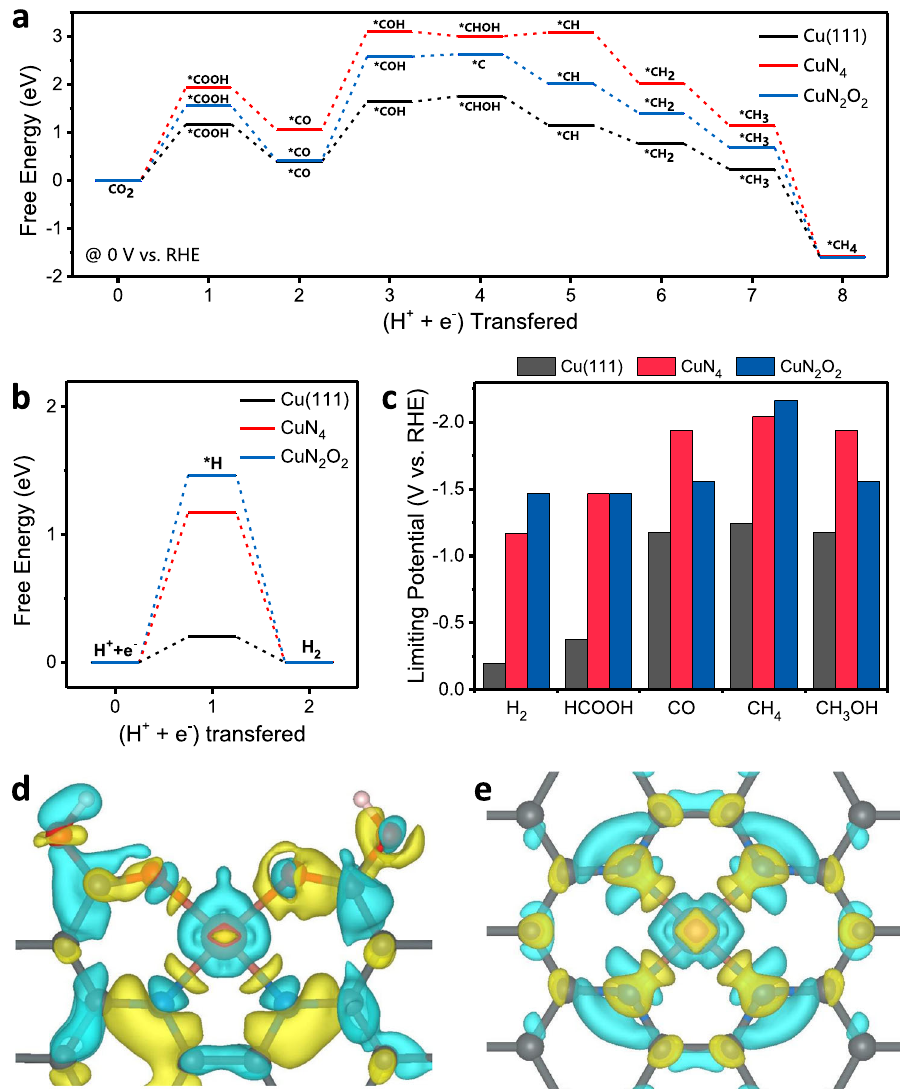
Fig. 5 Evaluation of catalytic activity by DFT simulations. Free energy diagram of the: a CO 2 reduction pathway to CH 4 and b hydrogen evolution on the CuN 2 O 2 (Cu-CDs), CuN 4 , and Cu(111). c Summary of the limiting potentials of the products of ECR and HER on the CuN 2 O 2 , CuN 4 , and Cu(111). 3D differential charge densities of: d CuN 2 O 2 and e CuN 4 . The yellow and blue isosurfaces correspond to the increase in the number of electrons and the depletion zone,